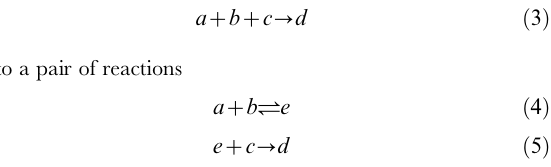
Table 1. Logical operations via chemical reactions.